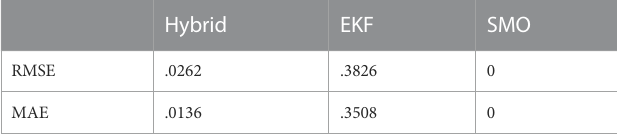
TABLE 5 Performance metrics of the hybrid estimation performance.